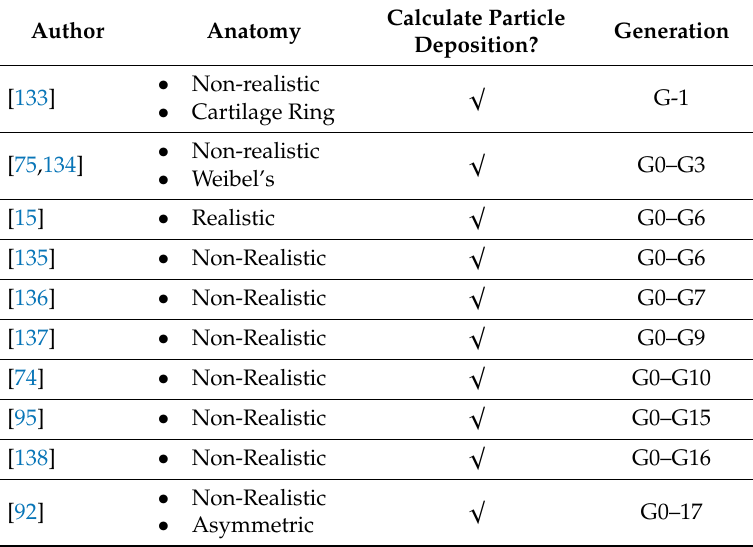
Table 3. A list of available literature on particle deposition up to maximum possible generations in human lung Calculate Particle Author Anatomy